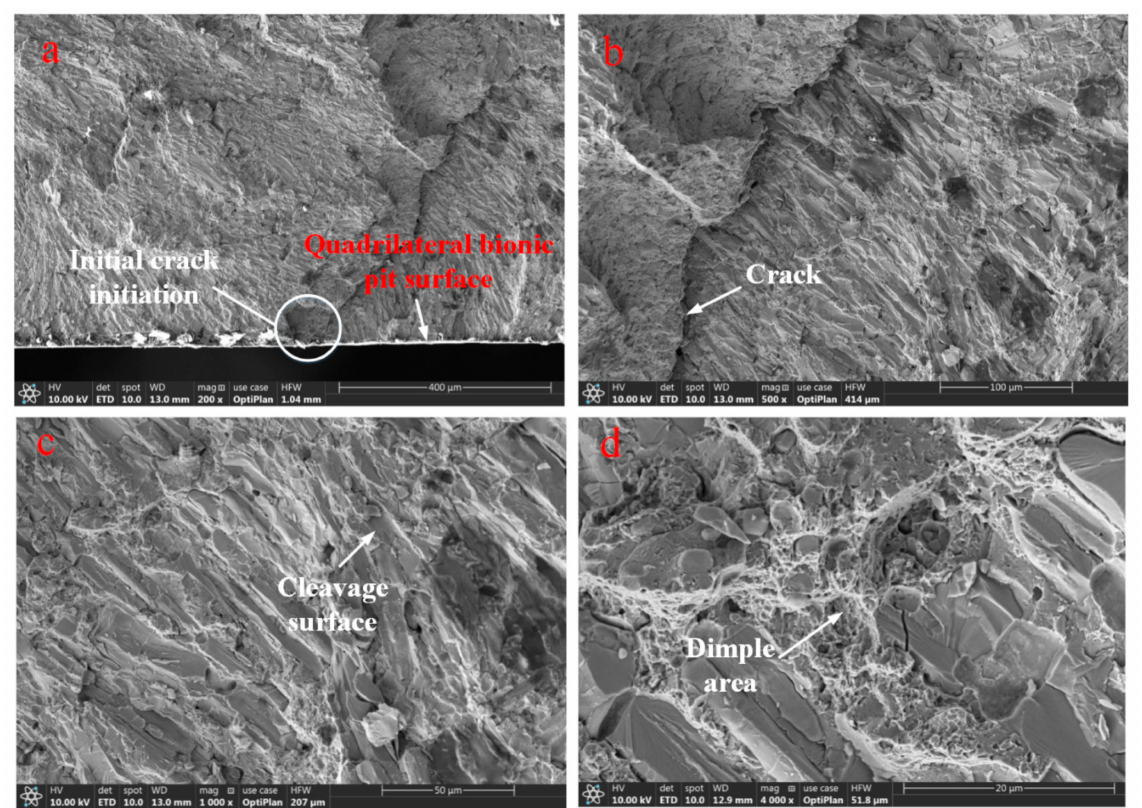
Figure 14. Observation results of microscopic characteristics of fatigue fracture of quadrilateral bionic pit morphology fatigue specimen: ( a ) observation results of macroscopic characteristics of fatigue fracture surface of quadrilateral bionic pit fatigue specimen; ( b – d ) observation on micro characteristics of fatigue fracture surface of quadrilateral bionic pit fatigue